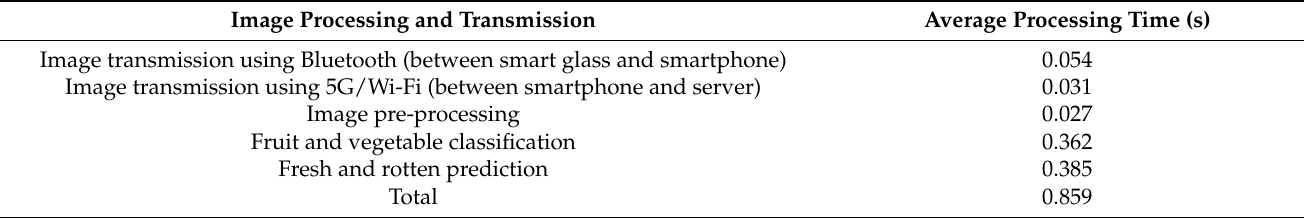
Table 8. Average frame processing time per sequence, measured in seconds. The average image input size is 640 by 640